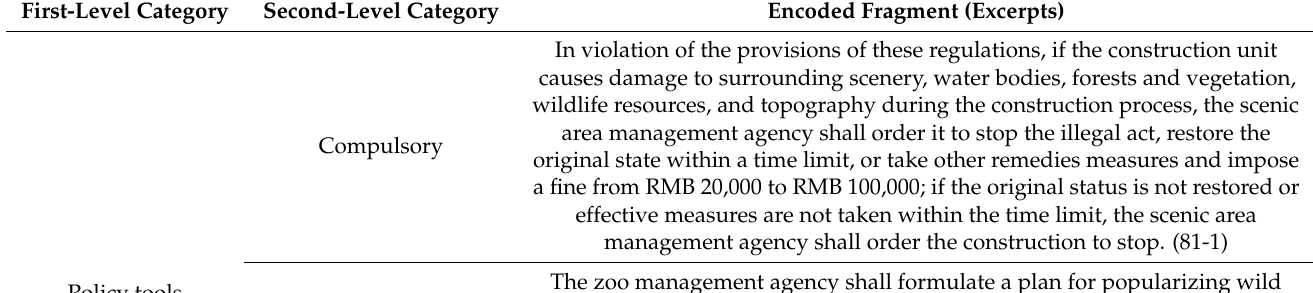
Table 2. Encoding of Content Analysis Units of Wildlife Management Policy Documents.